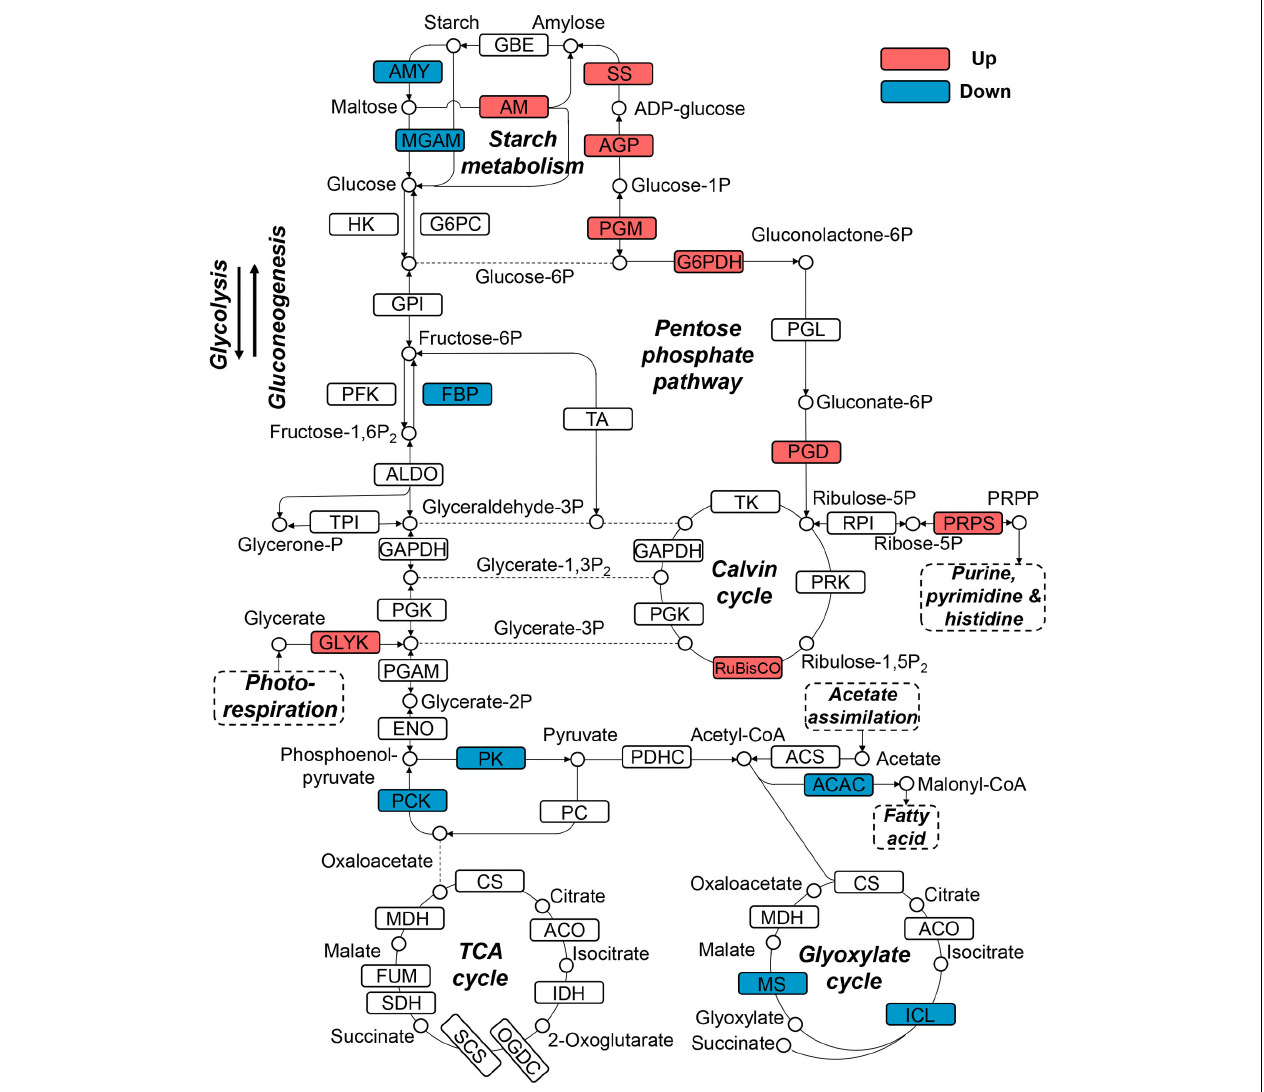
FIGURE 7 | Differentially expressed genes in central carbon metabolism in C. nivalis. Arrows represent the direction of reactions. Enzymes are marked by solid rectangles, and substrates and products are marked by circles. Dashed rectangles indicate pathways connected to carbon metabolism. Upregulated and downregulated genes are indicated by red and blue, respectively. ACAC, acetyl-CoA carboxylase/biotin carboxylase; ACO, aconitate hydratase; AGP: glucose-1-phosphate adenylyltransferase; ALDO, fructose-bisphosphate aldolase; AM, amylomaltase (4-alpha-glucanotransferase); AMY, beta-amylase; CS, citrate synthase; ENO, enolase; FBP, fructose-1,6-bisphosphatase; FUM, fumarate hydratase; G6PC, glucose-6-phosphatase; G6PDH, glucose-6-phosphate dehydrogenase; GLYK, glycerate 3-kinase; GPI, glucose-6-phosphate isomerase; HK, hexokinase; ICL, isocitrate lyase; IDH, isocitrate dehydrogenase; MDH, malate dehydrogenase; MGAM, maltase-glucoamylase; MS, malate synthase; OGDC, 2-oxoglutarate dehydrogenase complex; PC, pyruvate carboxylase; PCK, phosphoenolpyruvate carboxykinase; PDHC, pyruvate dehydrogenase complex; PFK, phosphofructokinase; PGAM, phosphoglycerate mutase; PGD, 6-phosphogluconate dehydrogenase; PGK, phosphoglycerate kinase; PGL, 6-phosphogluconolactonase; PGM, phosphoglucomutase; PK, pyruvate kinase; PRK, phosphoribulokinase; PRPP, phosphoribosylpyrophosphate; PRPS, ribose-phosphate pyrophosphokinase (PRPP synthase); RPI, ribose 5-phosphate isomerase; RuBisCO, ribulose-bisphosphate carboxylase; SCS, succinyl-CoA synthetase; SDH, succinate dehydrogenase; SS, starch synthase; TA, transaldolase; TK, transketolase; TPI, triosephosphate